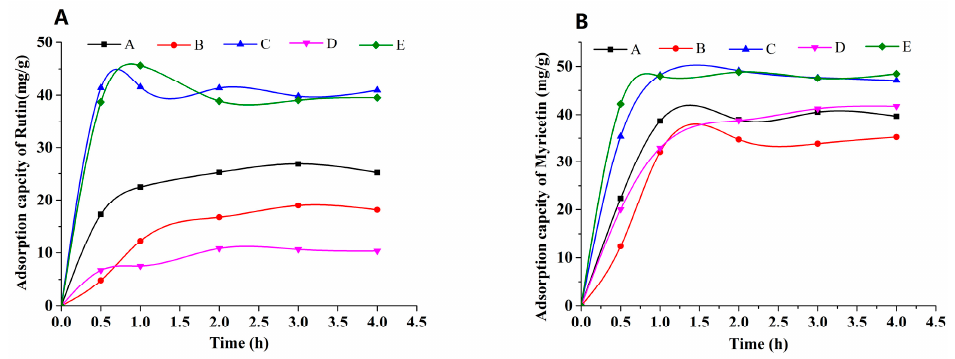
Figure 3. Adsorption capacity of rutin ( A ) and myricetin ( B ) on mixed-mode MARs (A–E: AUKJ-1 and BWKX-1 in 1:1, 1:1.5, 1.5:1, 1:2, 2:1 in turn).